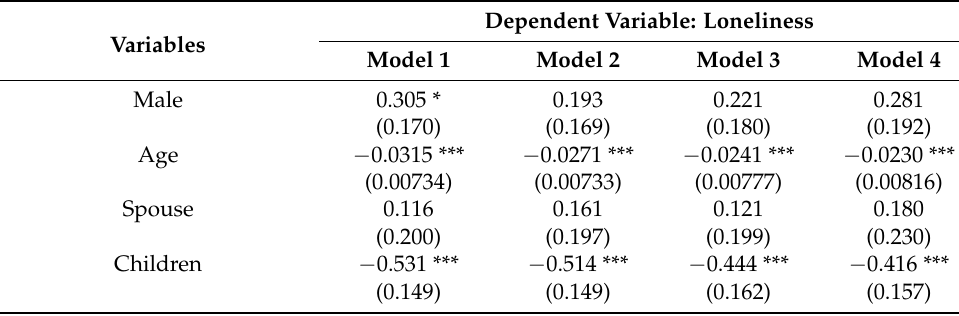
Table 5. Logit regression results of loneliness in 2021 (full sample